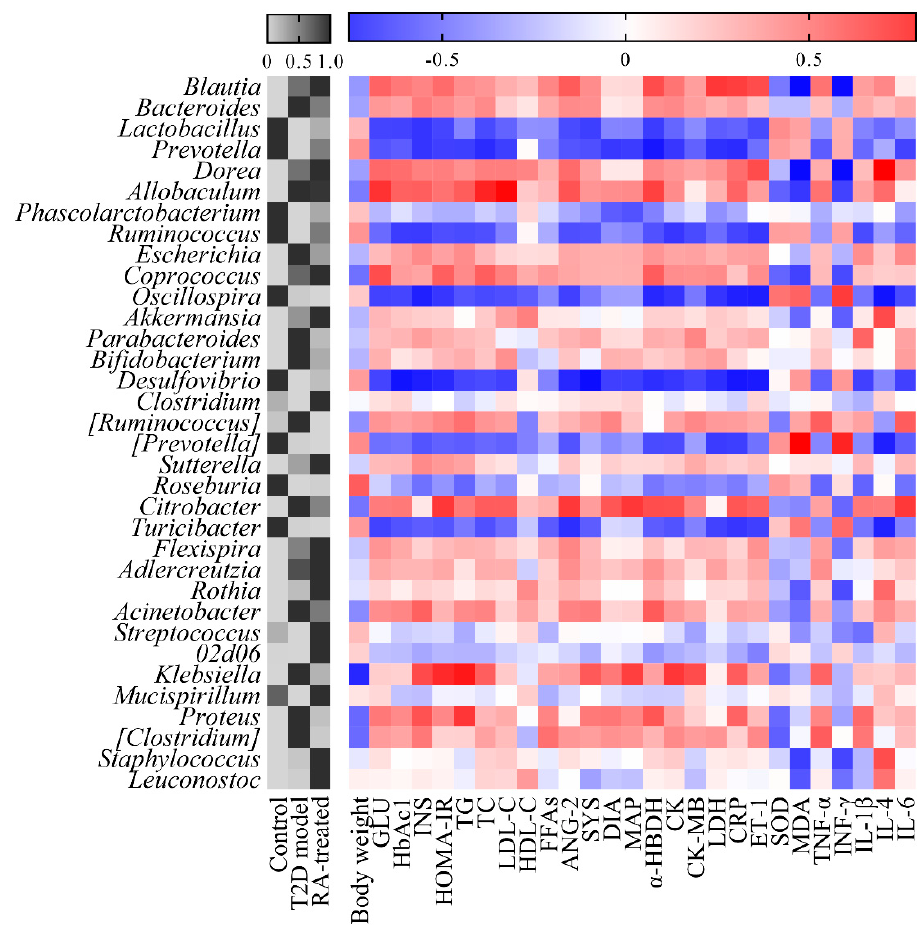
Figure 5. The heatmap of relative abundances of major genera in fecal samples of different groups are presented in gray levels after min–max normalization ( left ) and Spearman’s correlation value between relative abundances of major genera and biochemical parameters ( right ).